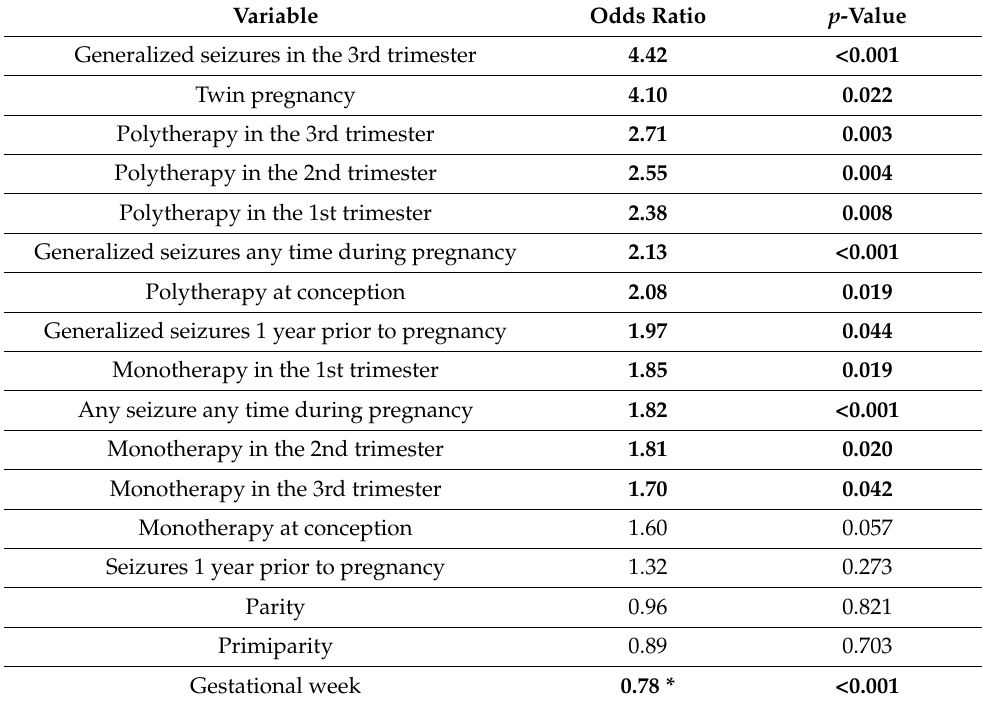
Table 2. Factors associated with caesarean section.